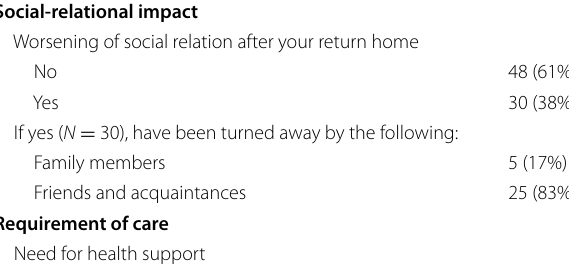
Table 4 Impact on social relations, economic status, and requirement of care in C-ARDS survivors at